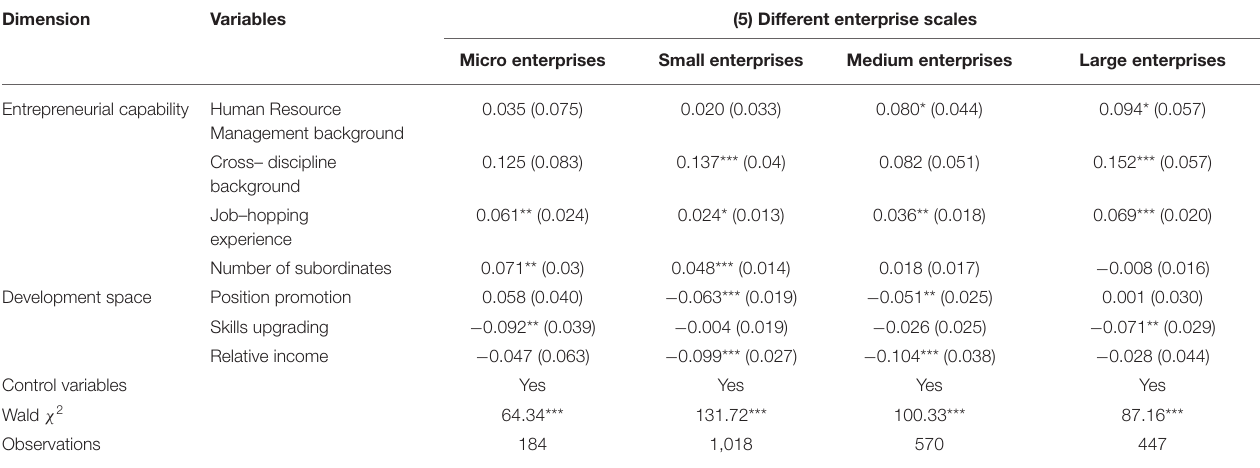
TABLE 5 | Heterogeneous analysis results for different enterprise